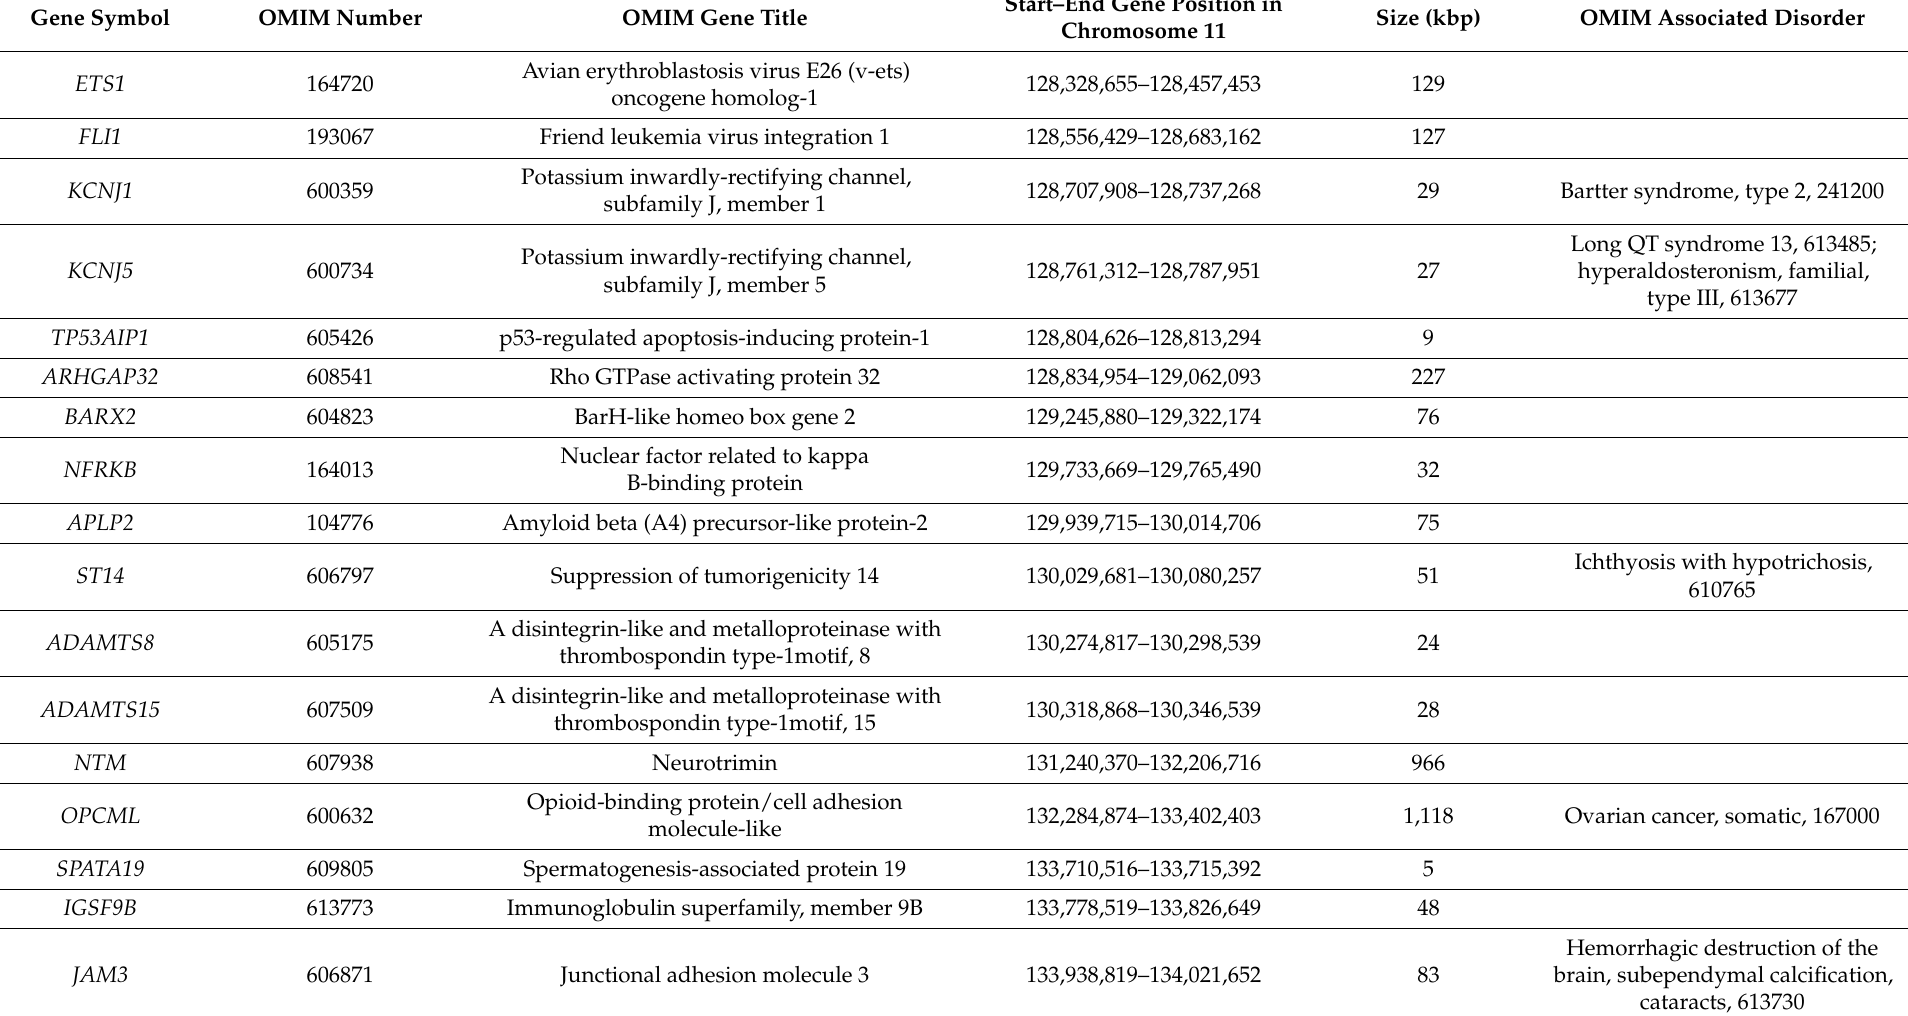
Table 1. Deleted OMIM genes in the 11q24.3q25 deletion in our JBS